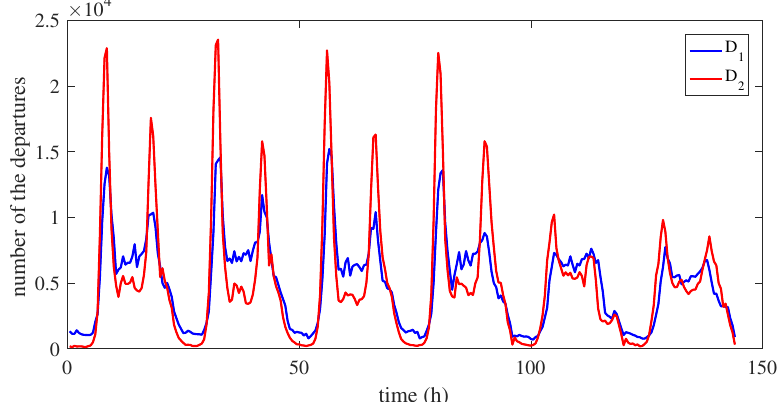
Figure 2. JS divergence of flow distance distribution at different times and the comparison between two distance distributions when JS divergence is the maximum. ( a ) JS divergence calculated from D 1 . ( b ) JS divergence calculated from D 2 . The time window of the blue line is 1 h, and the time window of the red line is 12 h. Each data point is the JS divergence calculated by the flow distance distribution in the current time window and that in the previous time window. ( c ) The comparison between two distance distributions when JS divergence is the maximum. The times of the two distance distributions are 04:00:00 and 05:00:00 on 27 May 2018 respectively.